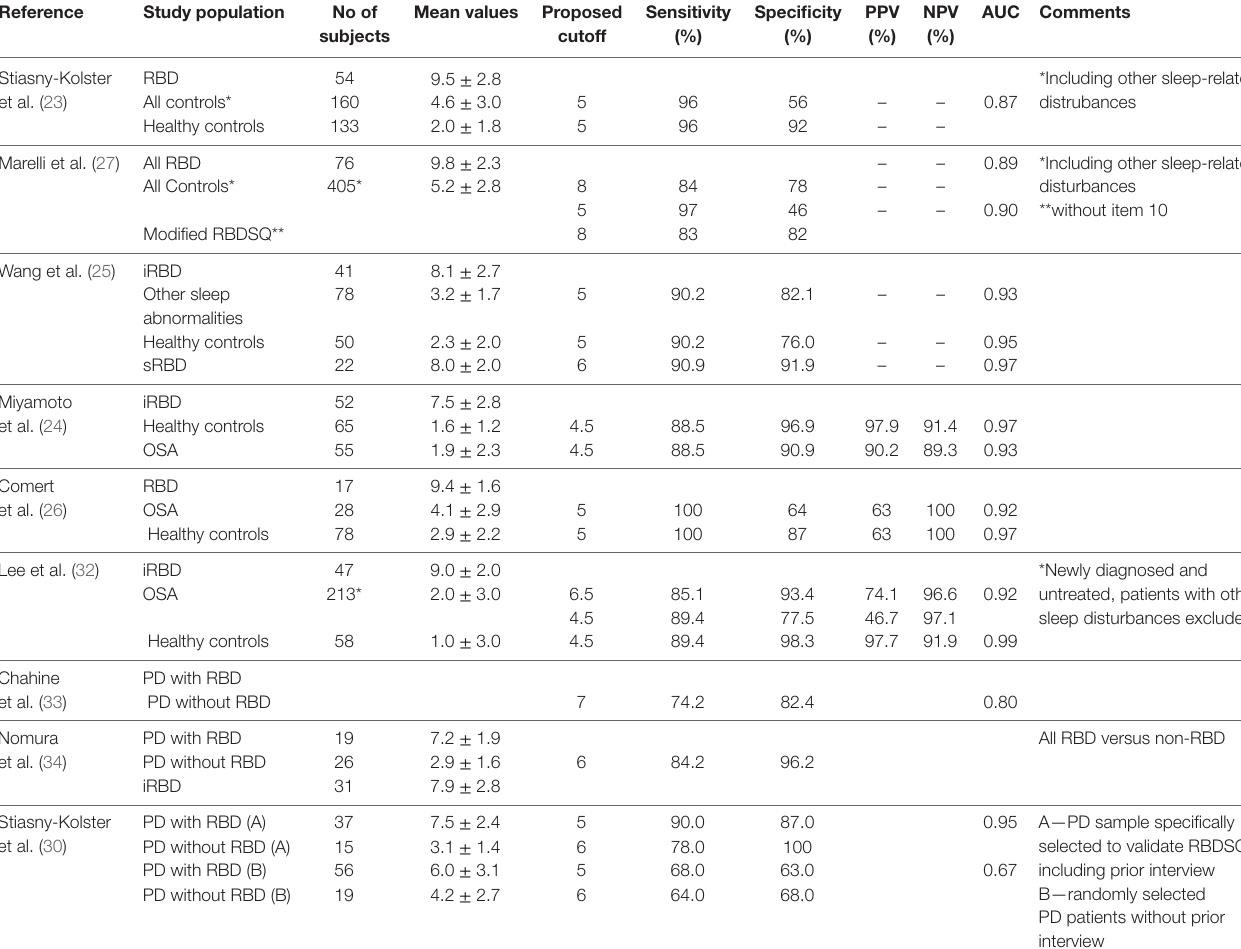
TABle 2 | Diagnostic accuracy of the Rapid Eye Movement (REM) sleep behavior screening questionnaire (RBDSQ).